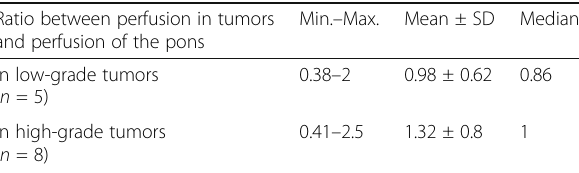
Table 2 Mean values (mean ± SD) and statistical results of regional cord blood volume in tumors and the pons. Ratio between perfusion in tumors and perfusion of the pons